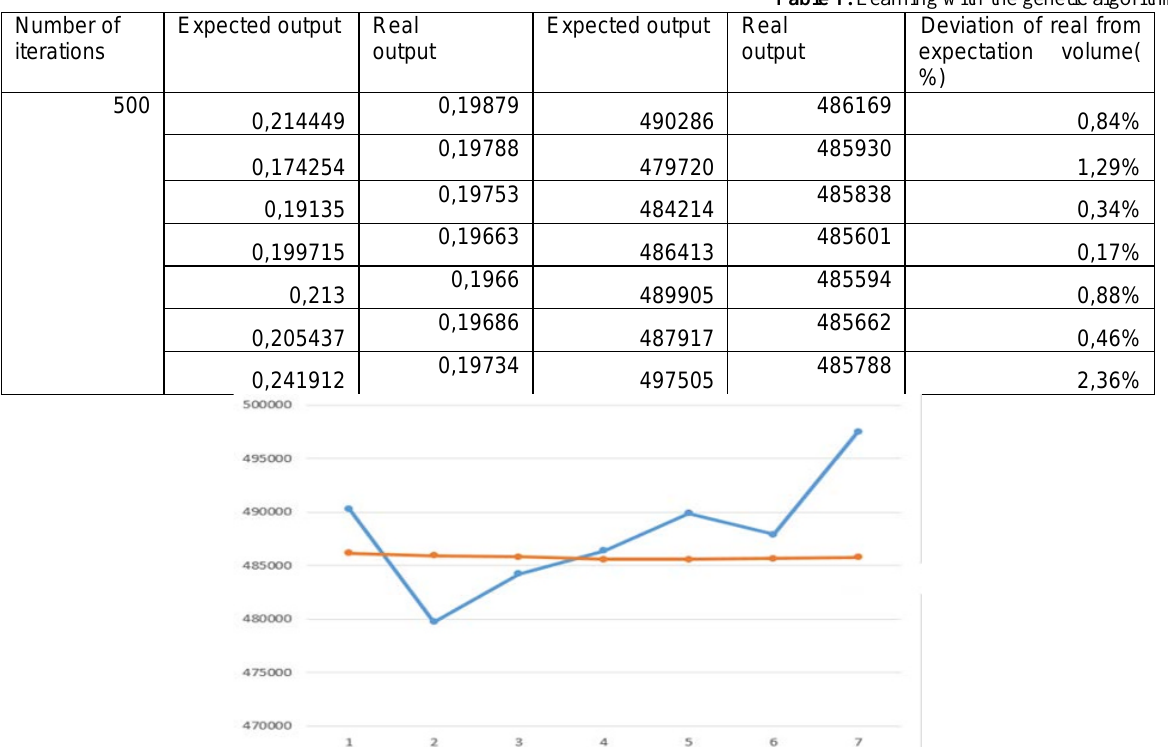
Table 1. Learning with the genetic algorithm